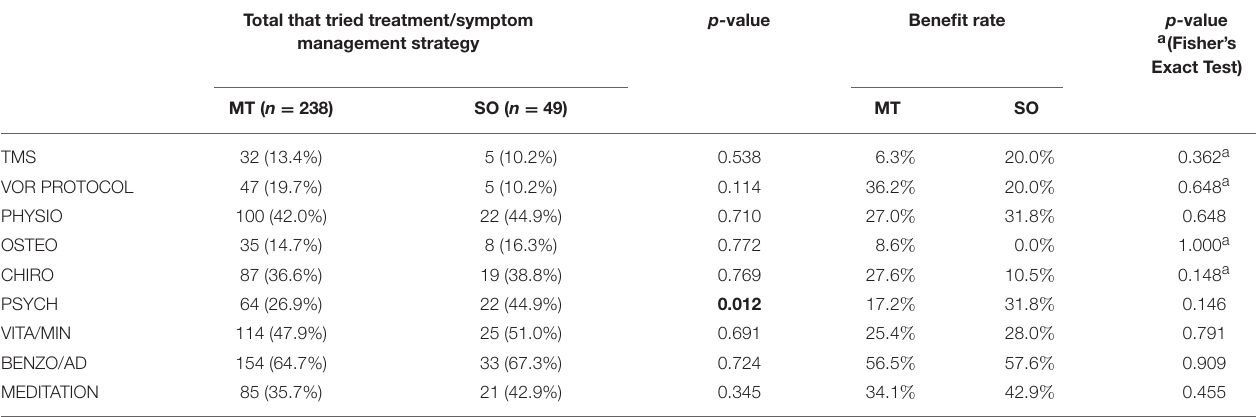
TABLE 2 | Trial rate and reported benefit rate (a reduction or relief of symptoms following treatment) for various current treatments and symptom management strategies used by MT and SO respondents to reduce their MdDS symptoms.